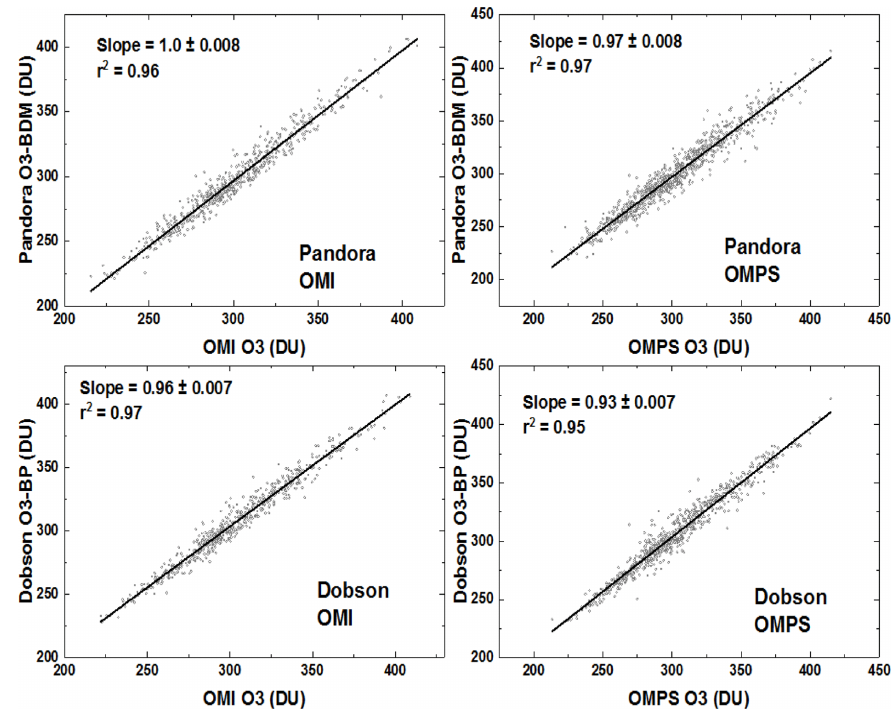
Figure 5. Correlation of Pandora #034 and Dobson #061 with OMI and OMPS for 2014–2016. Table 1. Percent difference summary of linear fit slopes and mean differences in Fig.